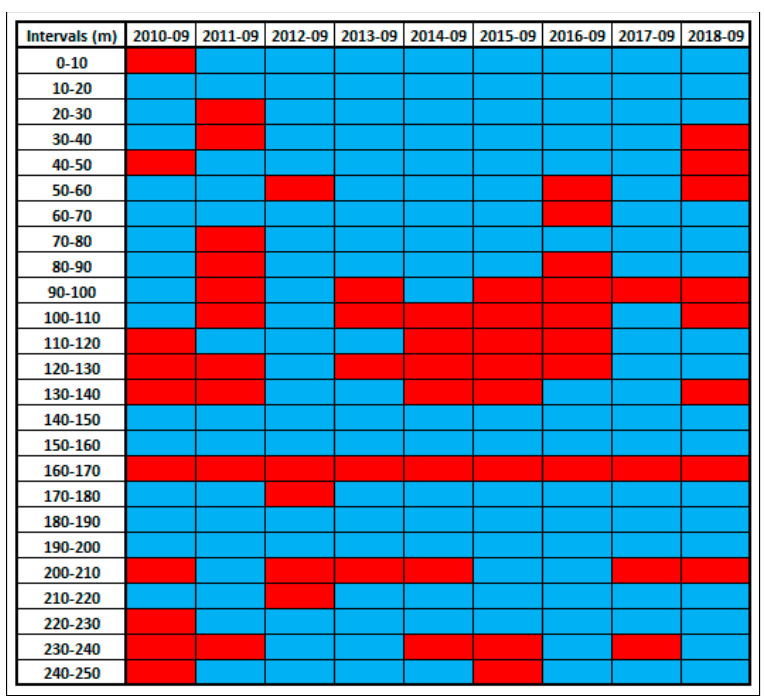
Figure 8. Annual evolution of profile 5 of cone B with respect to the year 2009. Red color indicates thinning and blue color indicates thickening.